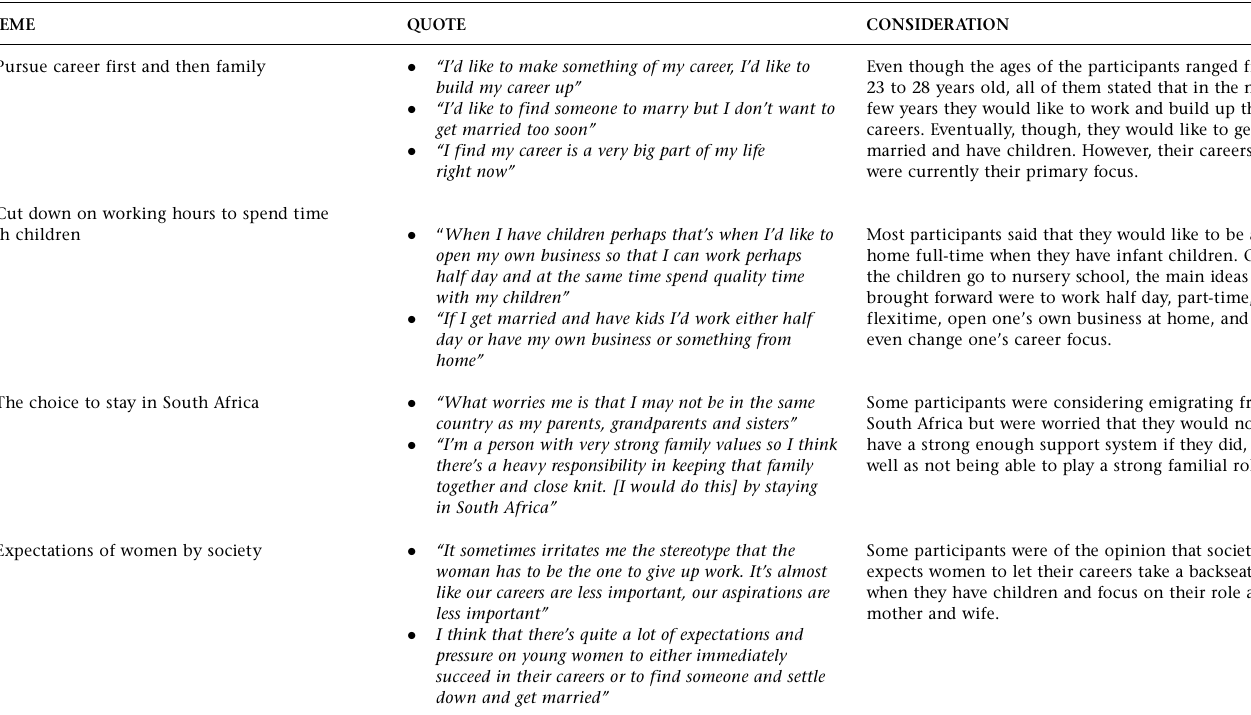
highlighted key phrases and words in the written transcript and then wrote categories in